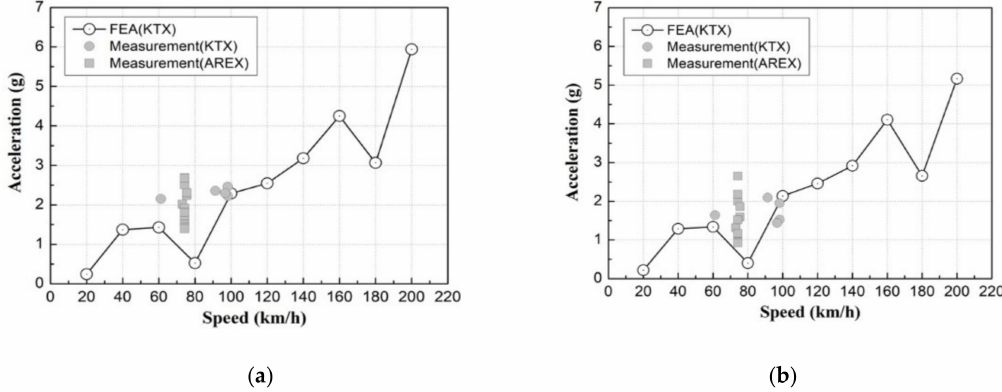
Figure 8. Analytical results of vertical and horizontal accelerations of rail and track girder. ( a ) Rail vertical acceleration; ( b ) Track girder vertical acceleration.